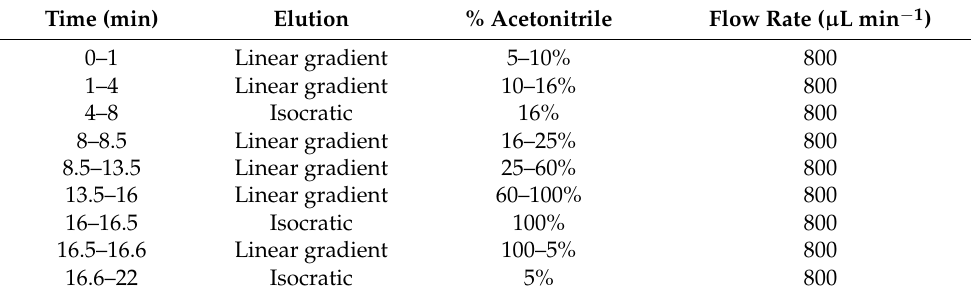
Table 2. Gradient elution